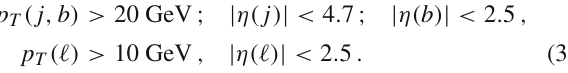
of the pseudoscalar decaying to flavor violating final states are strongly constrained (BR( A → μτ) ≈ BR( A → τ e )